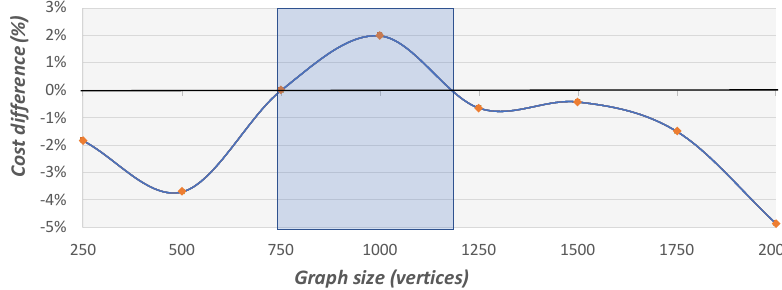
Figure 21. Cost difference comparison on graphs with different sizes and 0.15 density. This graph presents the average cost difference between the solutions of the GA and those of the 2-factor approximation method, which are marked by the fixed black line. The blue region represents graph sizes in which the 2-factor approximation method finds better solutions.